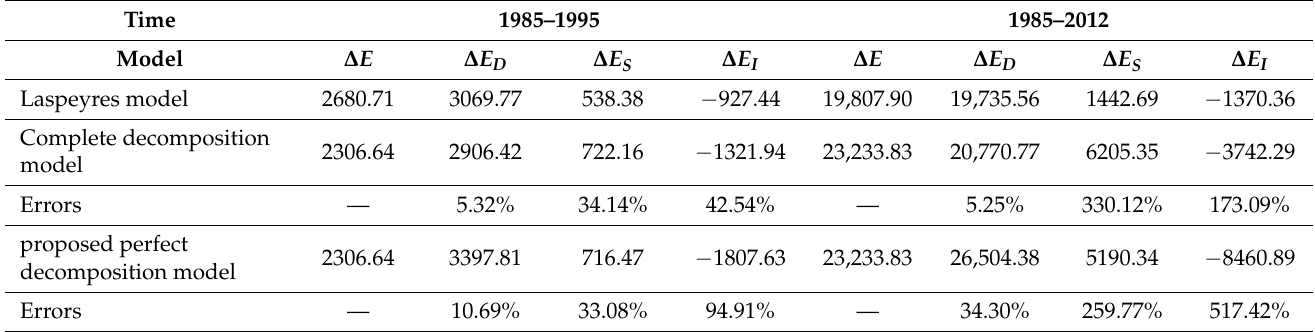
Table 1. The calculation results of the three decomposition